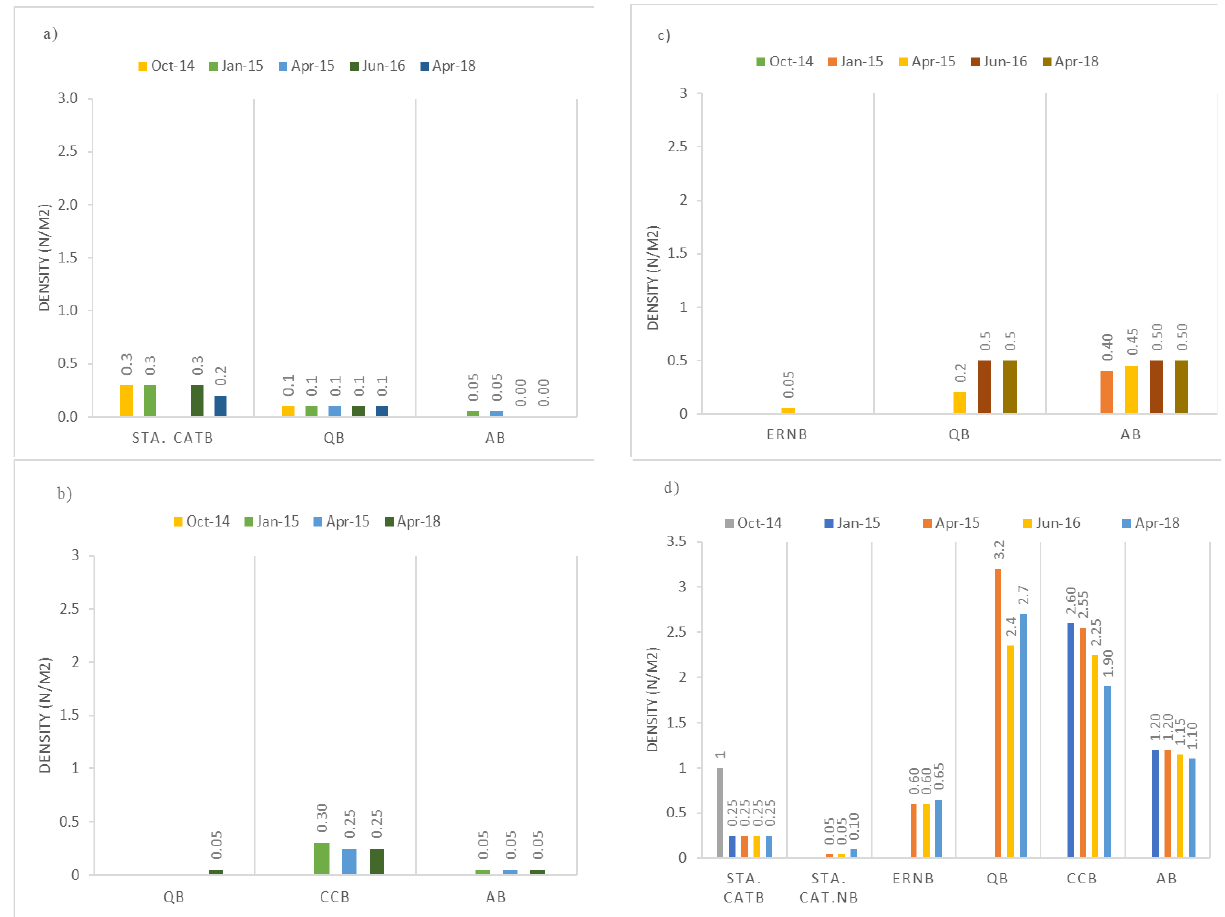
Figure 2. Density of individuals (no. individuals per m 2 ) of a) Cytisus scoparius , b) Retama sphaerocarpa , c) Rosmarinus officinalis , and d) Cistus ladanifer through four years of assessment (2014-2018). The pilot-plot abbreviation is as follows: Sta. Cat. , Sta. Catalina – Risco Grande (Burned); Sta. Cat. B burned); ER , Ermita (Not burned); Q , Solana de los Quejigos (Burned); CC NB B Atalaya